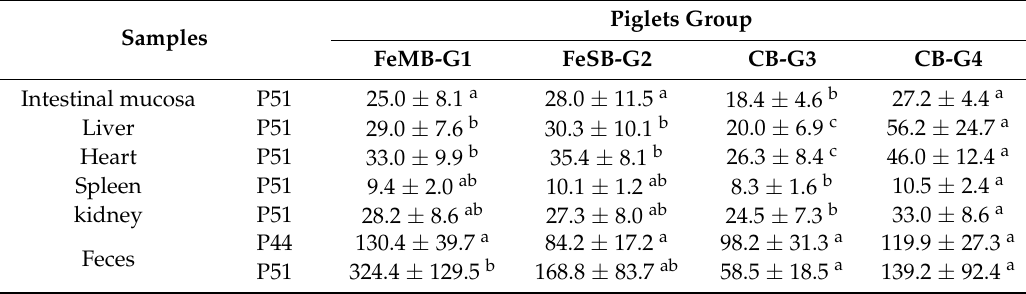
Table 5. Effects of dietary iron supplementation in the form of iron fortified bread and intramuscular injection on iron concentration (mg · kg − 1 · WM) in organs of post-weanling piglets. Values are expressed as means ± SD; Values in the same row with different superscripts differ significantly p < 0.05 ( n =